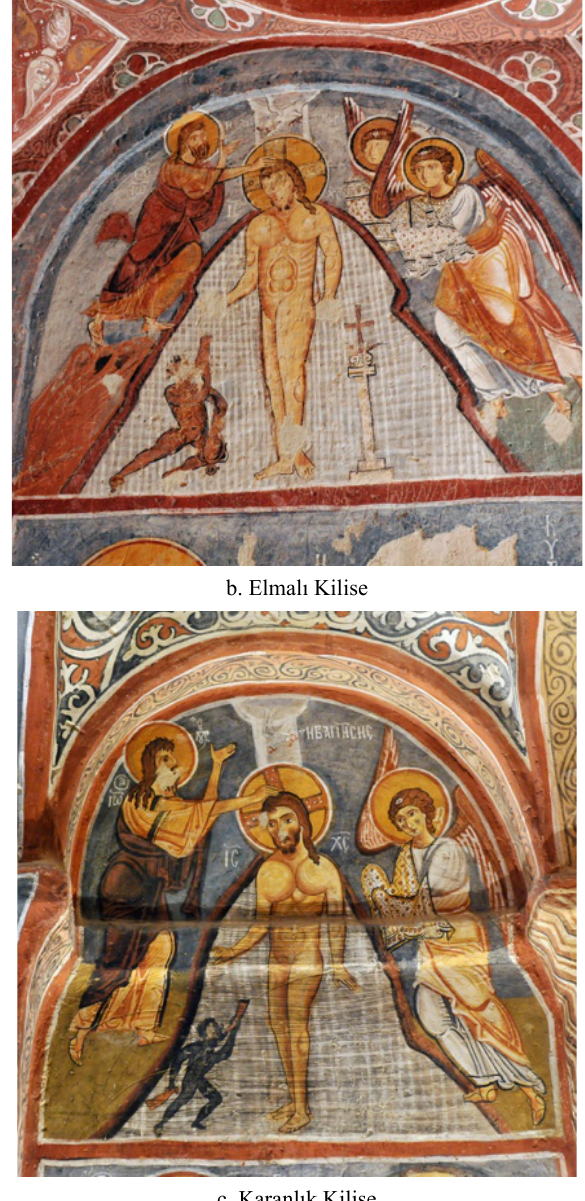
Figure 12. The Comparision of the current images of the Baptism of ‘Column